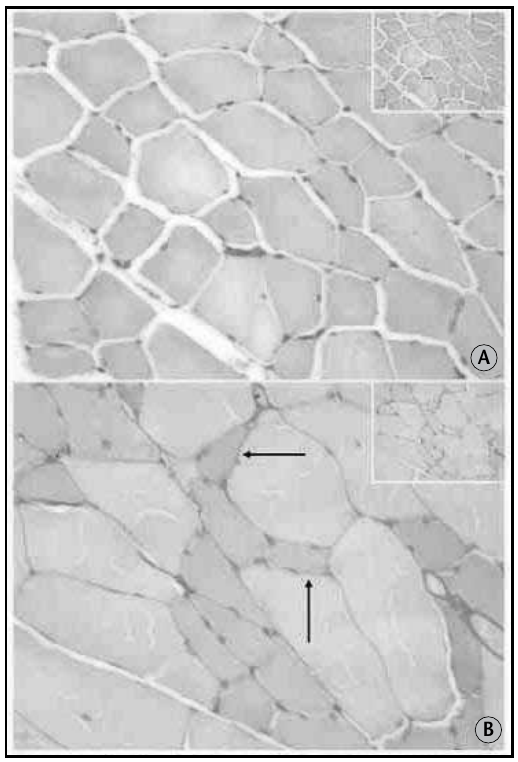
Figura 6 – Tecido muscular esquelético (A) grupo tibolona: fibras negativas para a reação de PAS. Inset: reação de PAS com amilase salivar negativa; (B) grupo-controle: algumas fibras PAS positivas (setas).